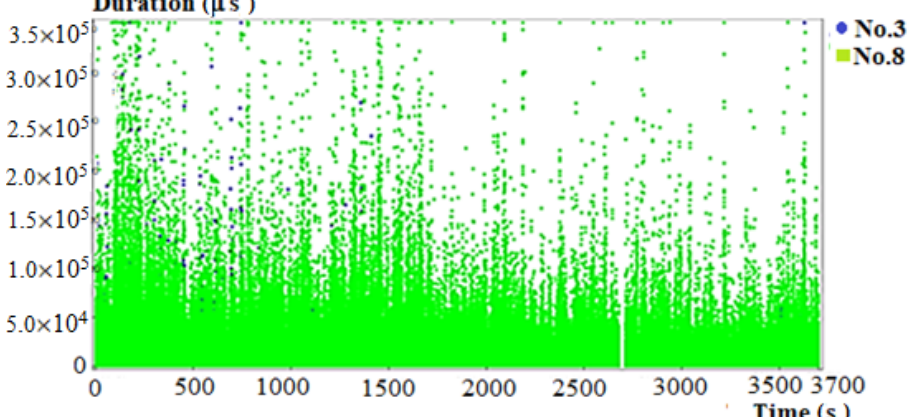
Figure 10. Signal strength versus time for sensors 1–12 on column 1 with the numbers of signal classes marked.